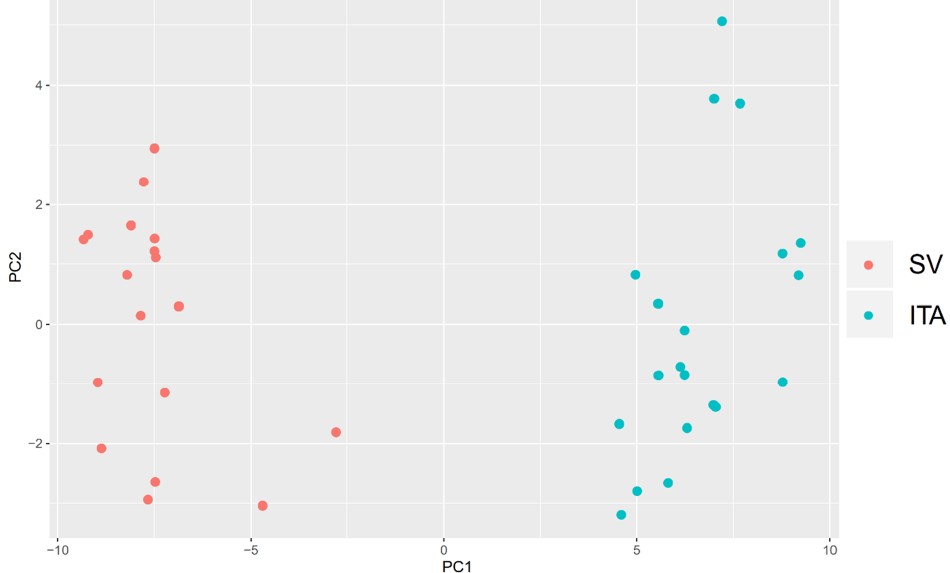
Figure 7. Principal component analysis (PCA) plot of significantly differentially expressed genes, based on the first two principal components’ (PC1 and PC2) loadings against each other. Each dot on the plot (red for saphenous vein (SV) and blue for internal thoracic artery (ITA)) means a single sample of the conduit used in the CABG procedure.